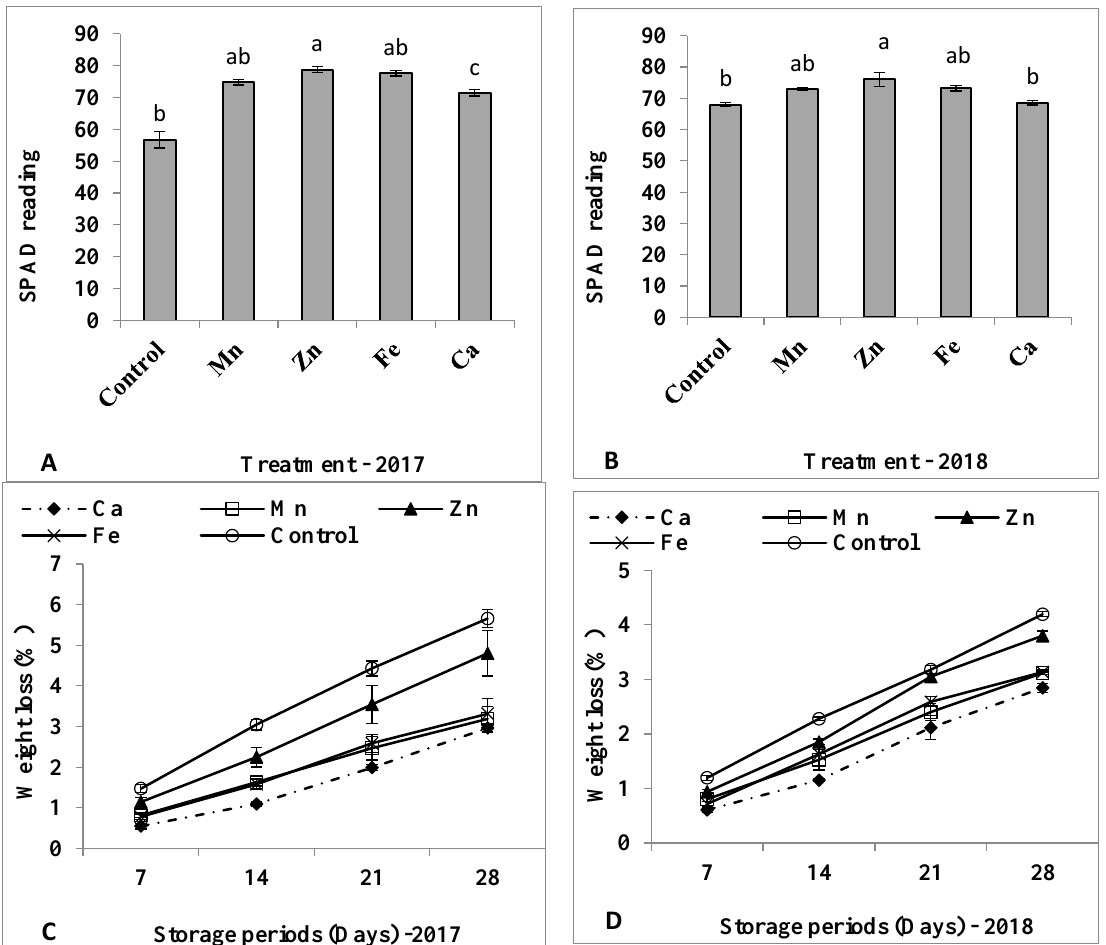
Figure 1. Effect of foliar application with Ca, Mn, Zn, and Fe elements on ( A ) Soil Plant Analysis Development (SPAD) reading of broccoli leaves at harvest stage in 2017, ( B ) SPAD reading in 2018, ( C ) weight loss of broccoli heads stored for 28 days at 4 °C in 2017, and ( D ) weight loss in 2018. Different letters indicate significant differences between treatments (Tukey test at p < 0.05).